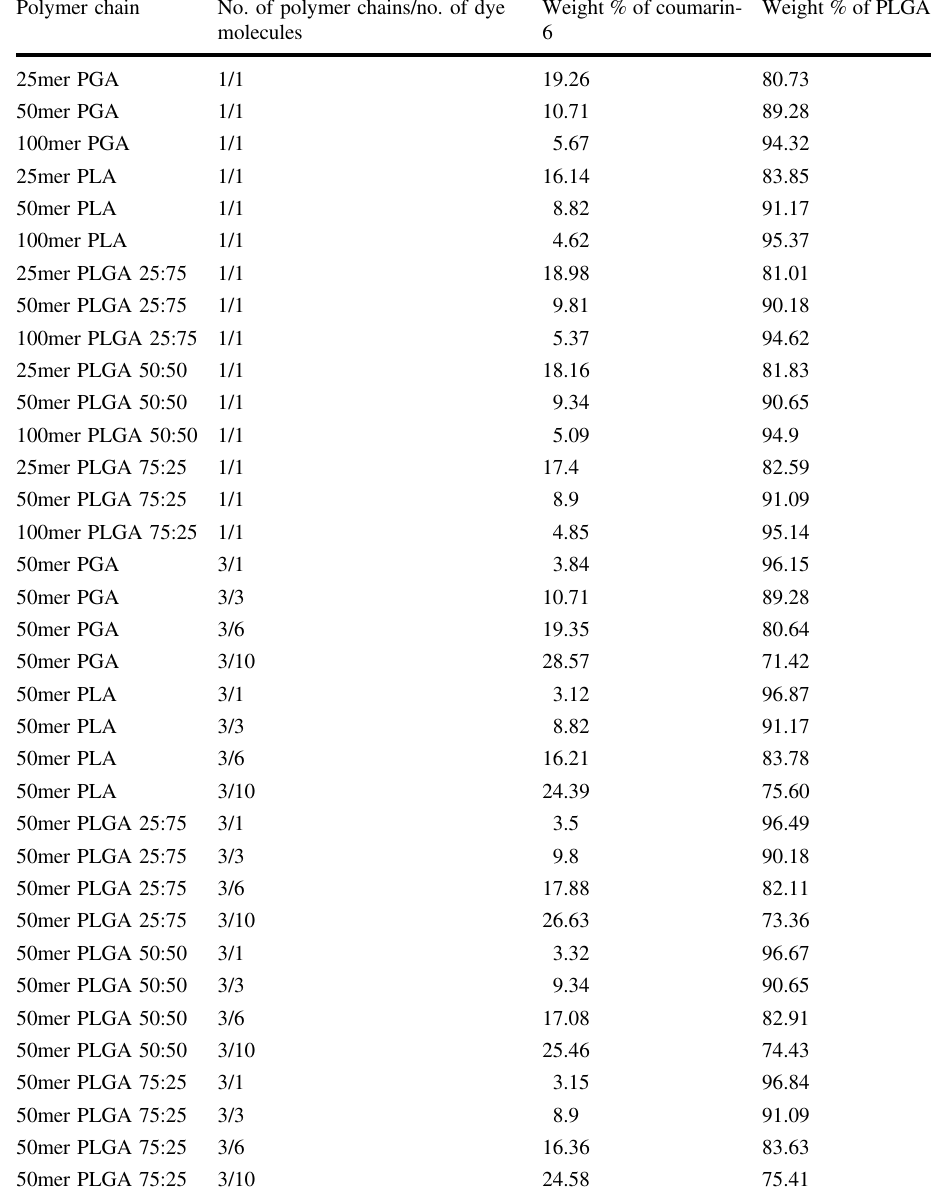
Polymer chain No. of polymer chains/no. of dye